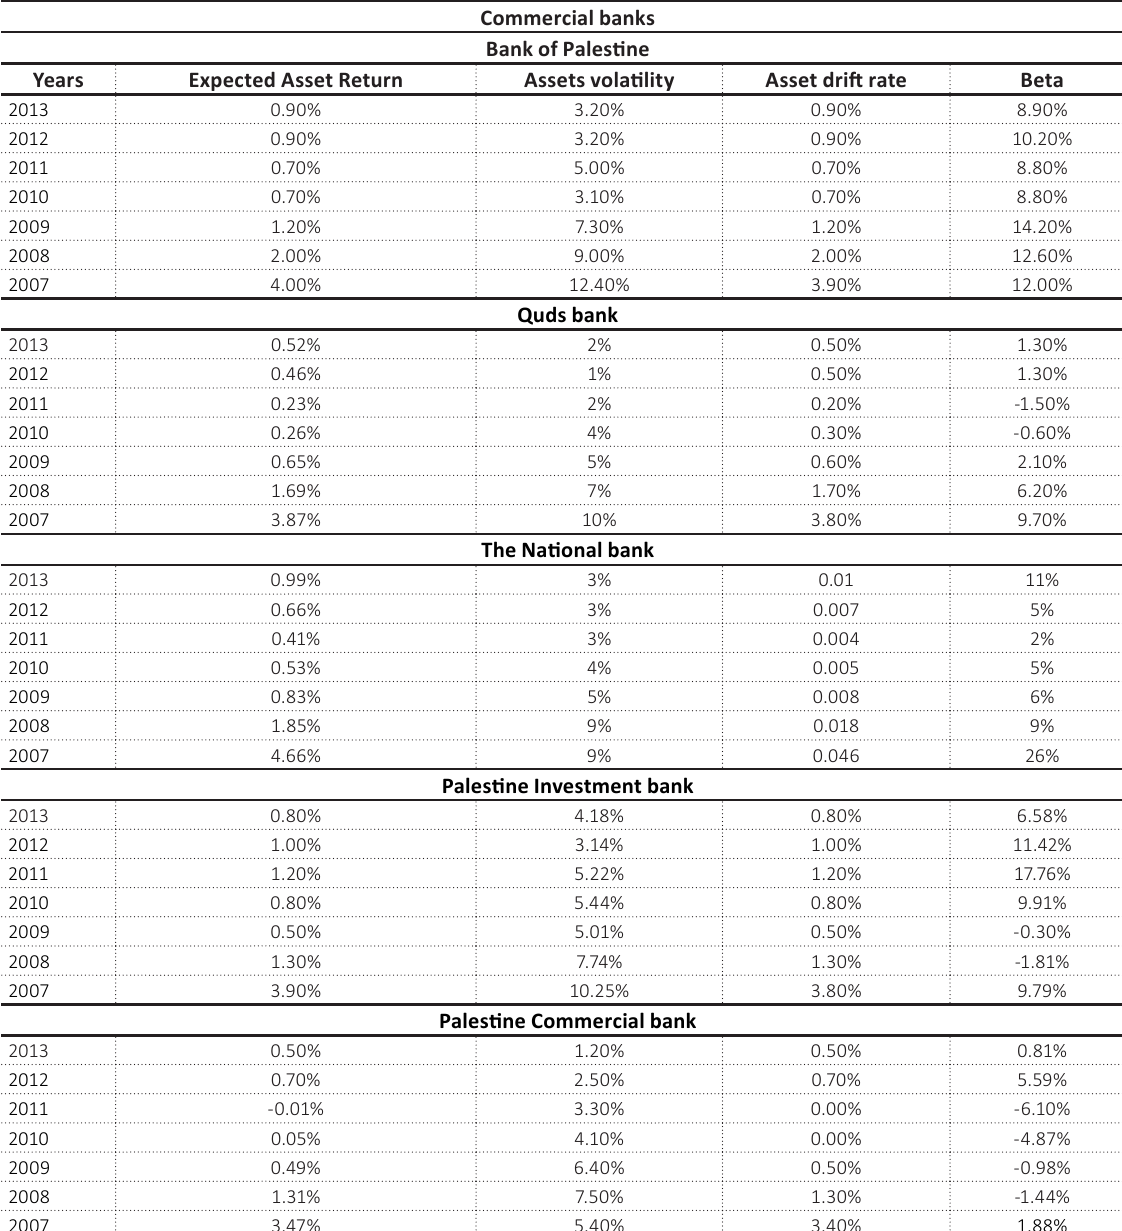
Source: Banks’ annual reports. Author